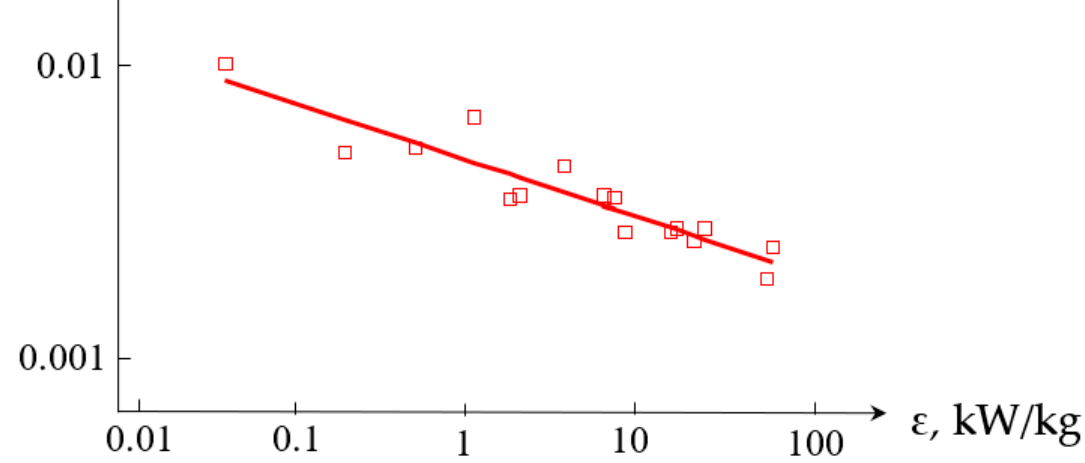
Figure 9. Dependence of the segregation index X s on the total flow rate Q 2 (m 3 /s) for liquids supplied to the upper tangential and axial (central) nozzles. Points—experimental data, line— X s = A 2 Q n 2 , where A 2 = 6.745 × 10 − 3 , n 2 = − 0.624.